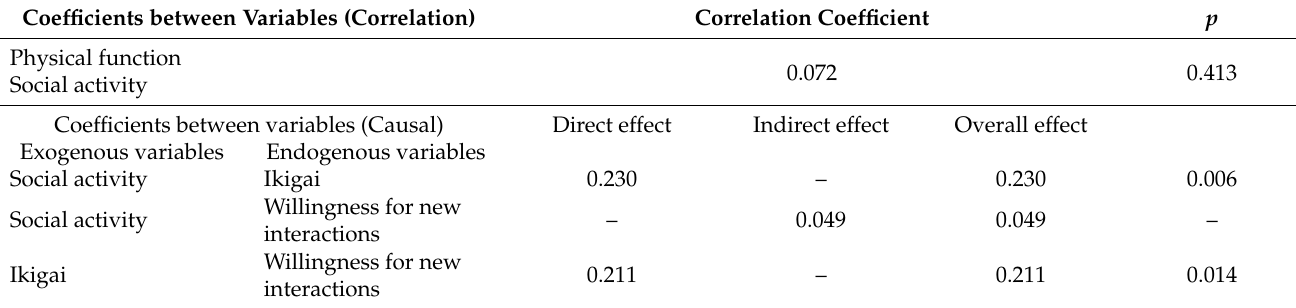
Table 3. Correlation and path coefficients of the modified model ( N =